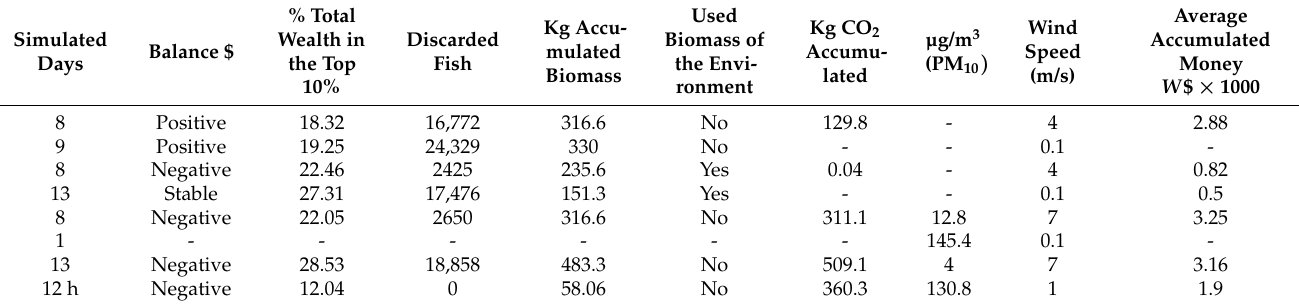
Table 12. Compilation of results presented in the different analyzed